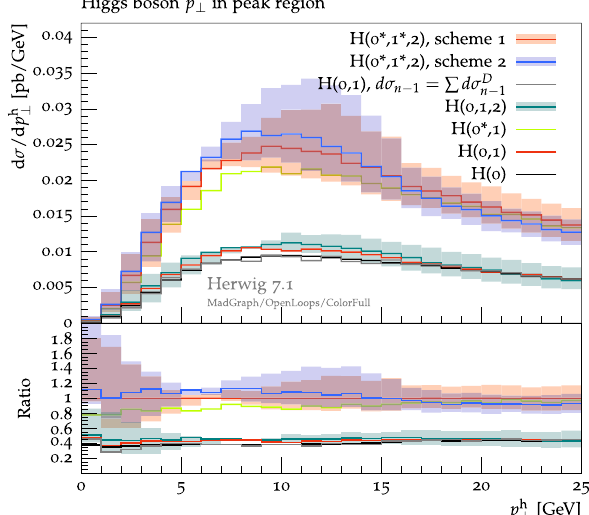
Fig. 25 The enormous K -factor of the Higgs production process and the process with an additional jet in combination with a merging scale that is close to the Sudakov peak leads to a kink at the merging scale. Switching the scheme from the preferred scheme for LEP and weak boson production to our scheme 1 shows a smoother contribution. Note that the choice of scheme is systematically beyond our